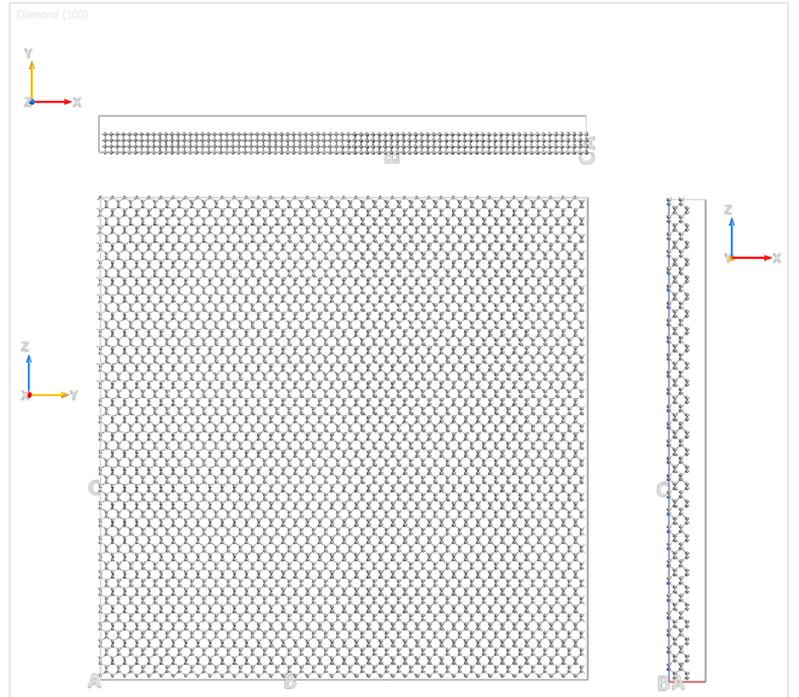
Figure 1 . Spatial orientation of the diamond substrate.